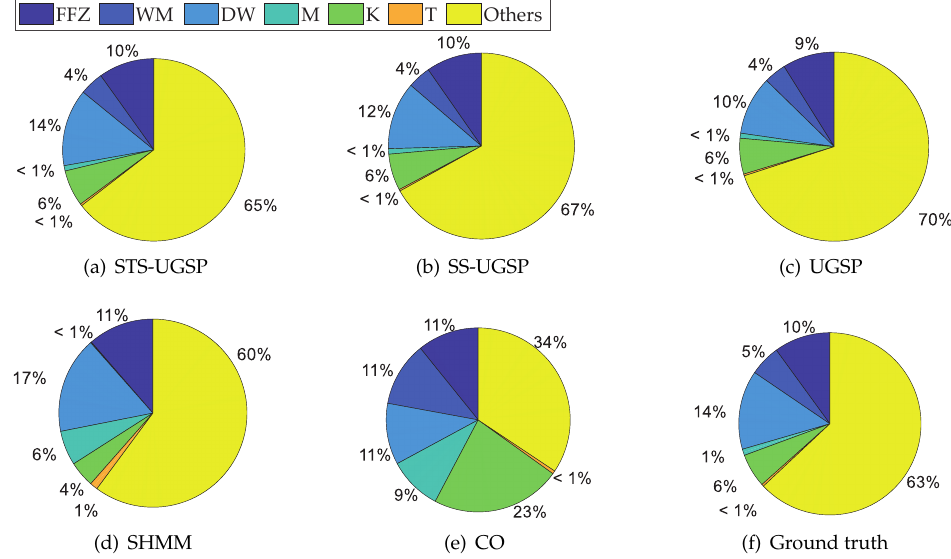
Figure 8. Pie charts of disaggregated energy shares for REFIT House 2.